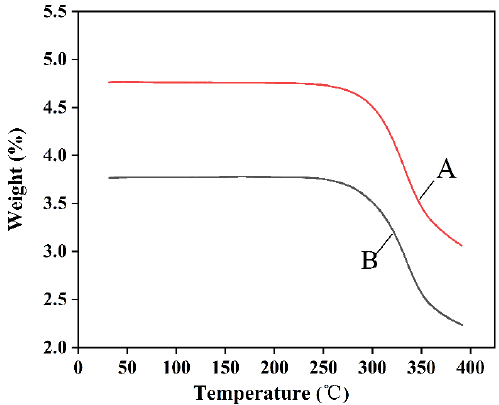
Figure 7. DSC curves of raw naringenin ( A ) and NUP ( B ).